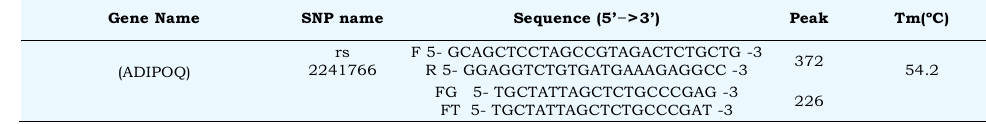
Table 1 The name and sequence and melting point of prepared ADIPOQ (rs 2241766) gene